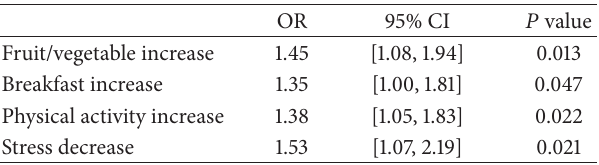
Table 4: Logistic regression predicting ≥ 5% weight loss by health behavior